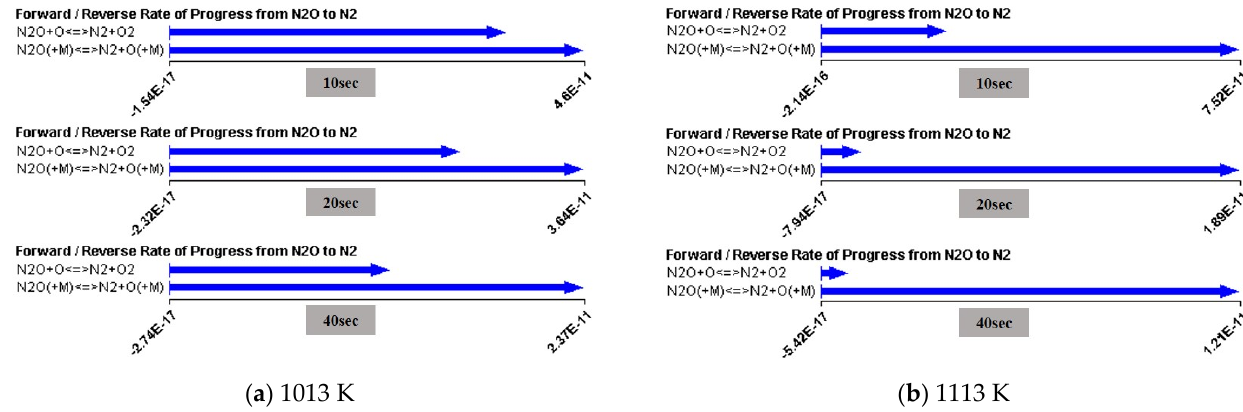
Figure 6. Rate of progress from N 2 O to N 2 (M/cm 3 s) at 1013 and 1113 K.